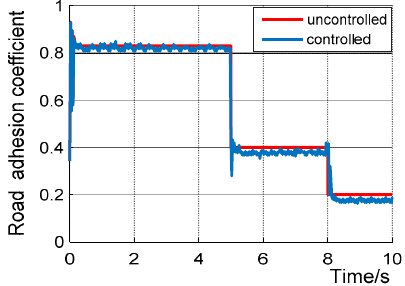
Figure 18. Road adhesion coefficient curve.